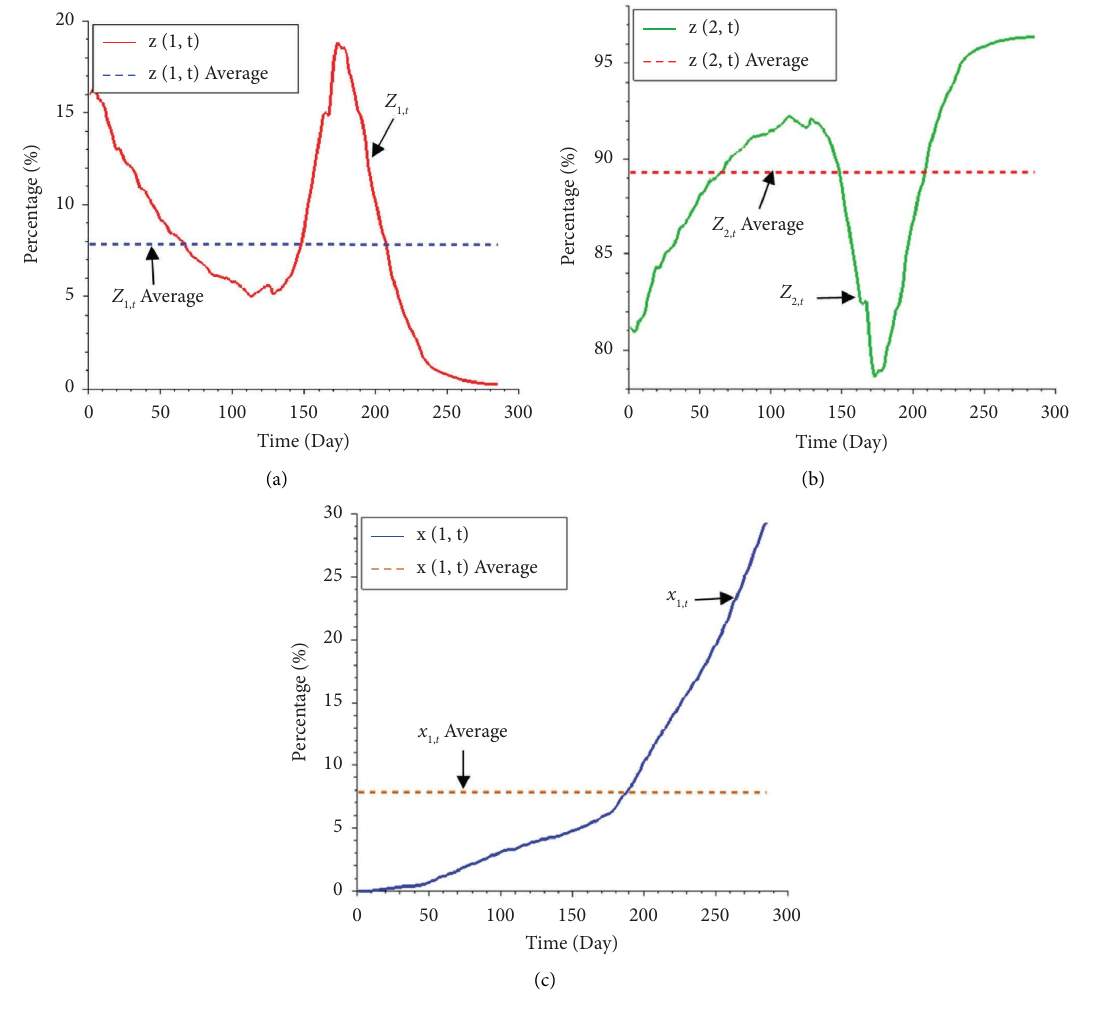
(a), z (b), and x 1 ,t 2 ,t